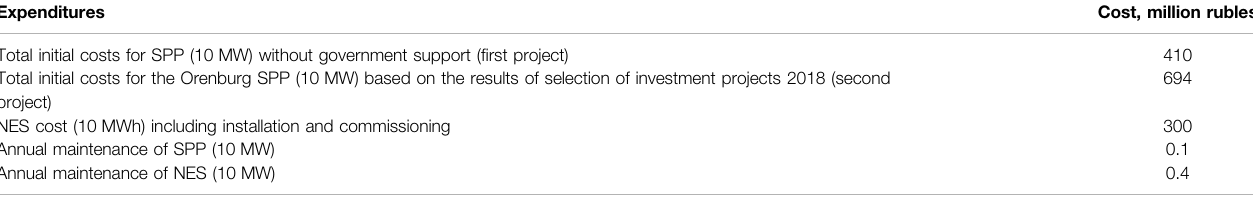
TABLE 1 | Solar power plant construction and maintenance costs. Expenditures